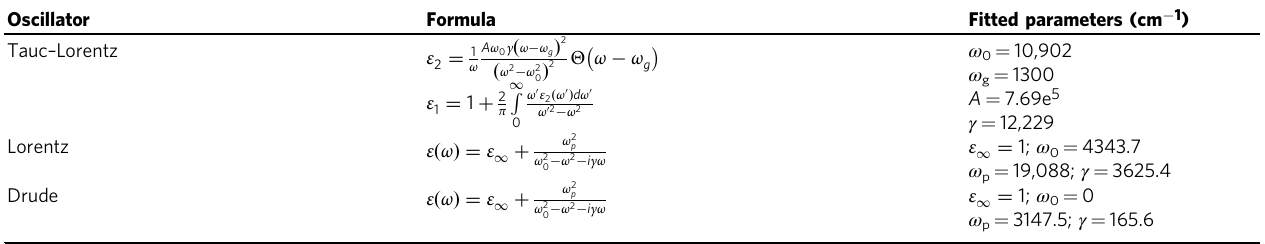
Parameters of the oscillators used to model the dielectric function of Bi 2 Te 3 crystals throughout the optical spectral